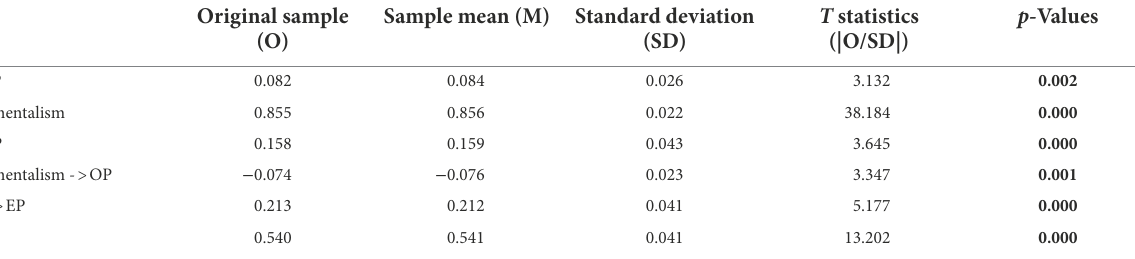
TABLE 3 Structural model